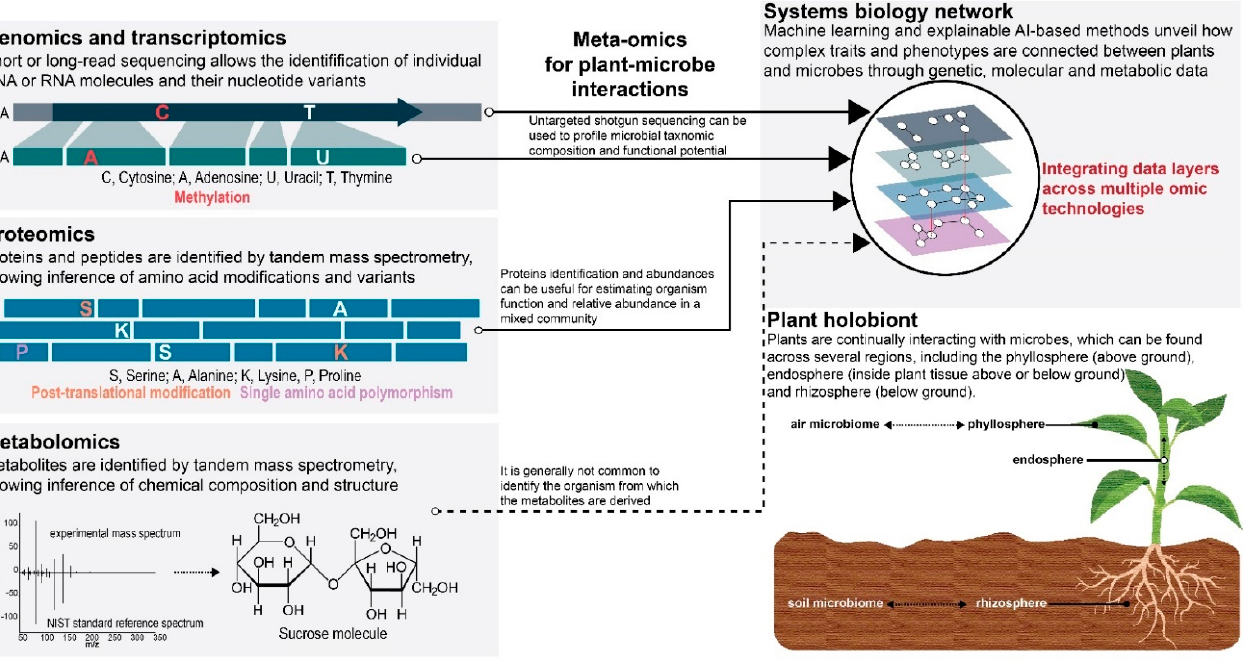
Figure 1. The application of major omic technologies and their integration provide complementary data necessary for dissecting complex traits and phenotypes associated with plant-microbe interac- tions. The promises and challenges of each omic technology will be influenced by the genetic, func- tional, and environmental complexity inherent to the biological system being studied.